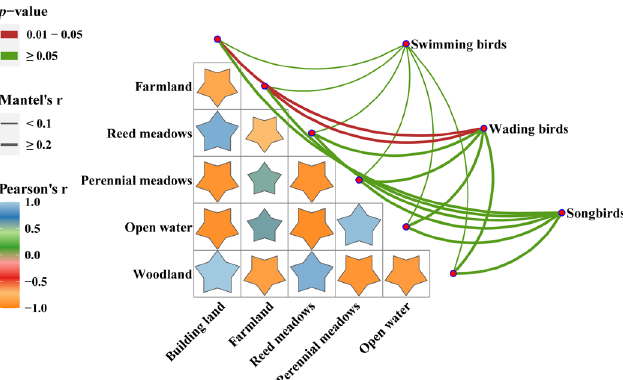
Figure 7. Correlation between ecotypes and habitat types by Mantel test. Pearson’s r represents the correlation coefficients among different habitat types; Mantel’s r reveals the correlation coefficients between ecotypes and habitat types, and the thicker the line is, the larger the correlation coefficients are; p -value represents the significance of the correlation between ecotypes and habitat types.